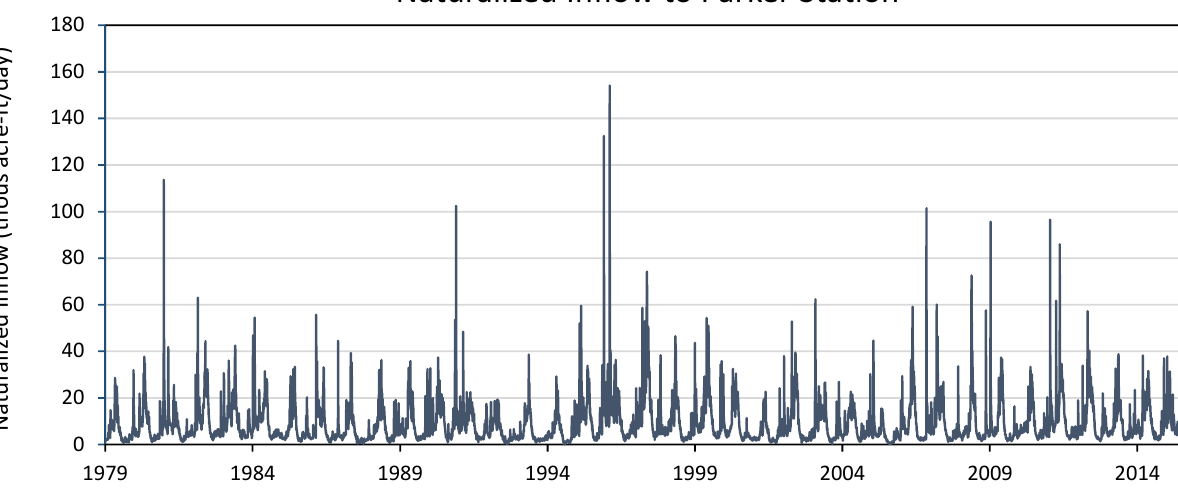
Figure A11. Input data—naturalized inflow to Parker station calculated by the Variable Infiltration Capacity (VIC) model (assuming no regulation or irrigation impacts) from the YRB headwaters were obtained from the Yakima Hydromet program [62] .